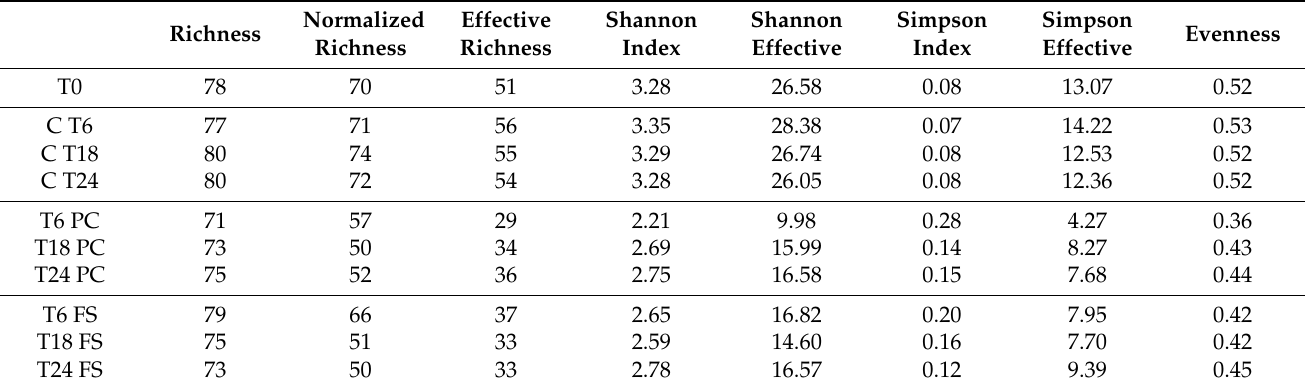
Table 1. Alpha diversity changes of human gut microbiota batch cultures observed over 24 h (T0, T6,